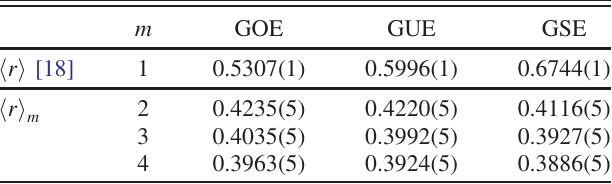
TABLE II. Values of averages h r i for m blocks, as obtained from simulations on random matrices. The value for m ¼ 1 is taken from Ref. [18]. Notice the excellent agreement with the surmise results reported in Table I.